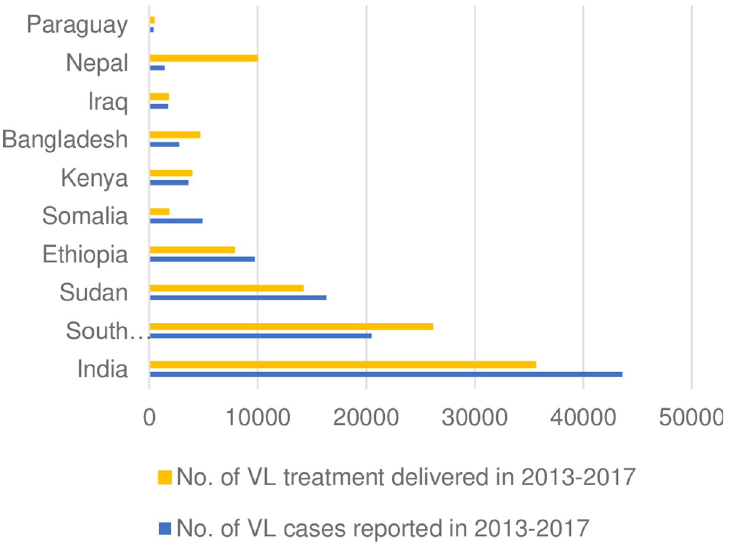
Fig 2. Supply and demand in top 10 VL countries, 2013–2017. (A) Antimonials are used to treat both VL and CL in Paraguay and Iraq. (B) We assumed that VL patients were treated with priority. (C) Where sodium stibogluconate and paromomycin is used in combination to treat VL, the number of treatments delivered is estimated based on the number of paromomycin vials procured and delivered, as sodium stibogluconate is also used to treat CL. (D) CL: cutaneous leishmaniasis; VL: visceral